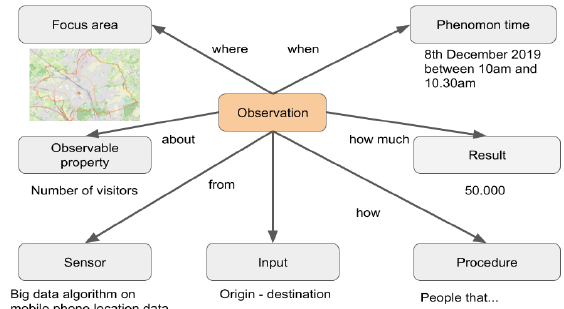
Fig. 1: Example observation related to urban bustle expressed with SSN concepts.